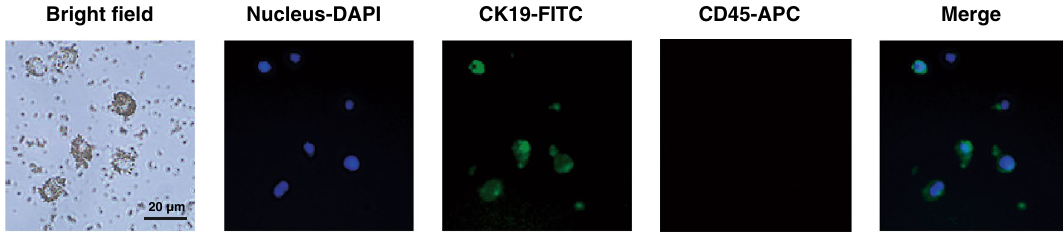
Figure 1. Images of IMN-captured and immunofluorescence-stained CTCs from a patient peripheral blood